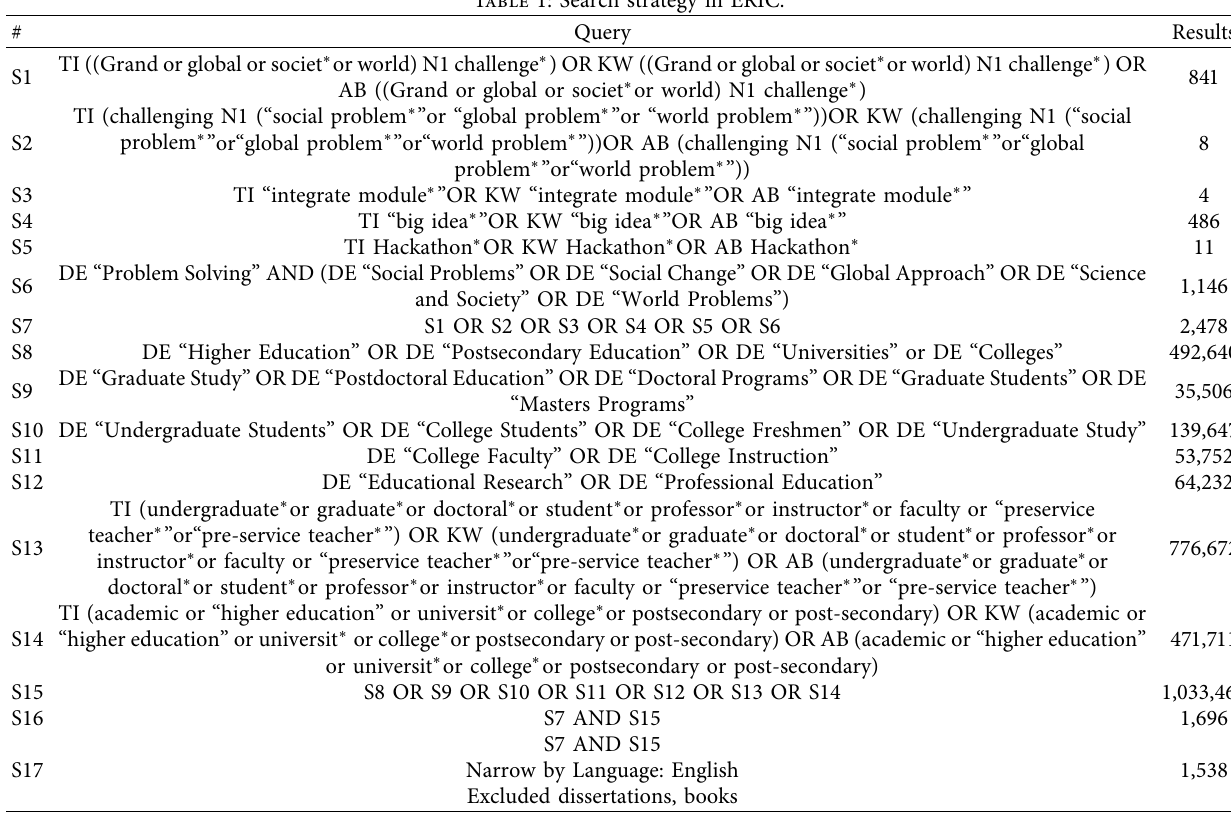
Table 1: Search strategy in